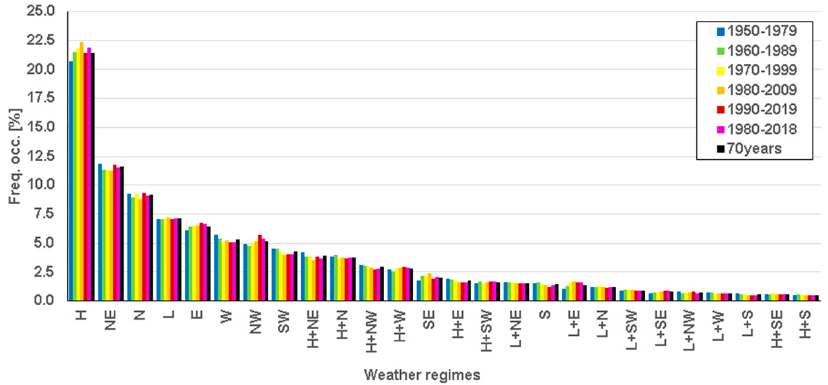
Figure 5. Weather circulation type frequency of occurrence by consecutive 30-year period of data the period of observational wind power capacity data (1980–2018).